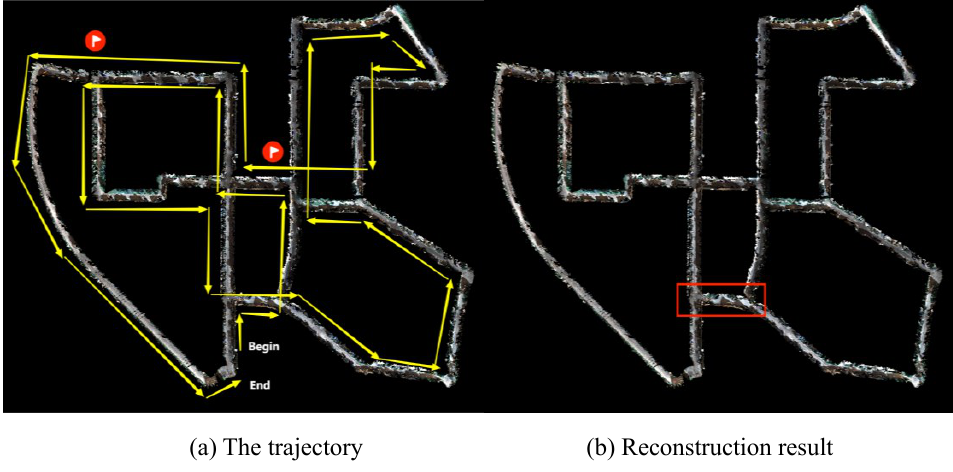
Figure 6. Reconstruction results of KITTI odometry sequence 00. ( a ) Motion trajectory of the camera. ( b ) Point clouds of reconstruction. The area in the red frame of ( b ) is the revisit